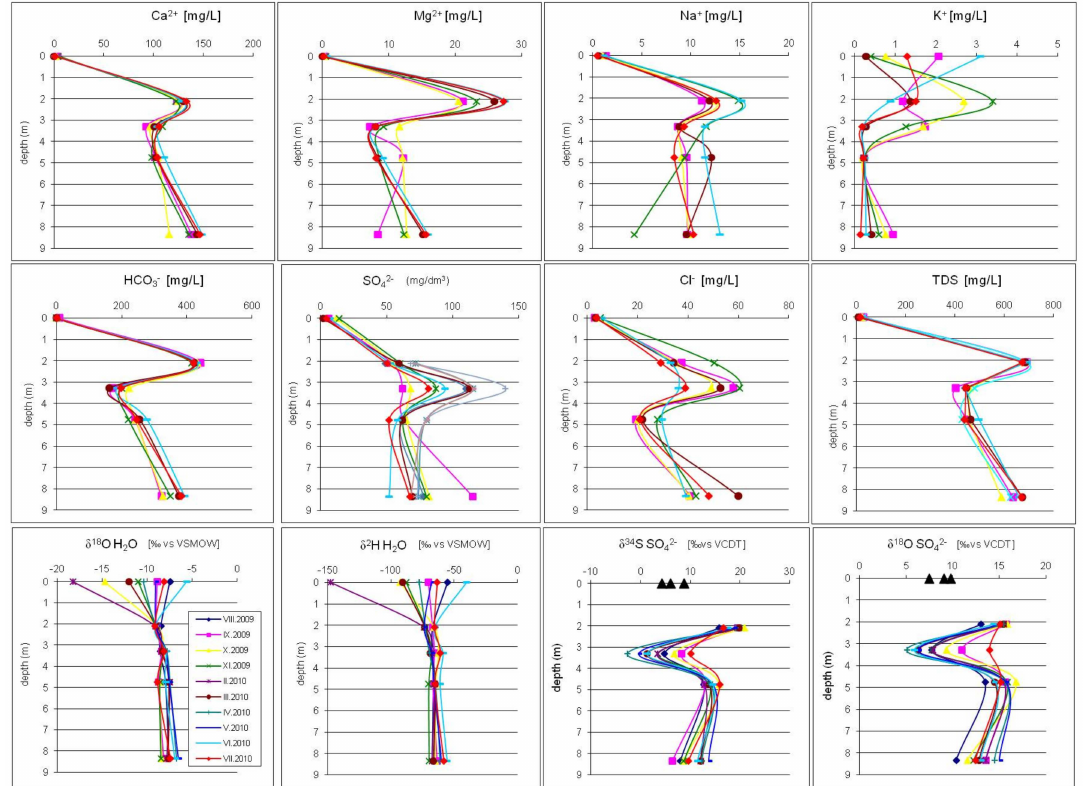
Figure 4. Seasonal variations of chemical and isotopic composition of groundwater in the Po˙zary aquifer with depth. The values for rainwater are shown at depth 0.0 m. For more explanations see the